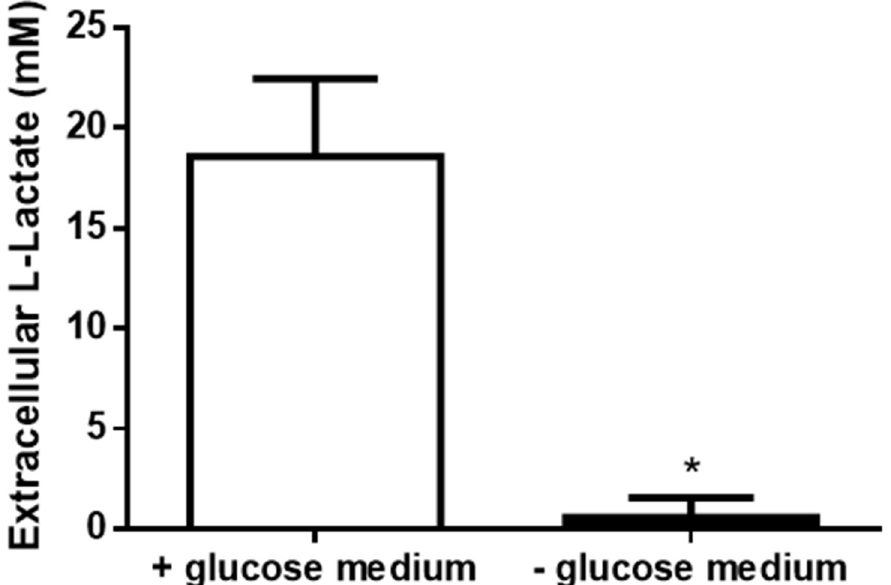
Fig 4. Effect of glucose starvation on lactate levels. Extracellular lactate level in pII cells upon culture in + glucose medium (open bar), or—glucose medium (solid bar) for 1 day was determined as described in Methods. Histobars represent means ± SEM of at least 3 independent determinations. � denotes significant difference from cells cultured in + glucose medium, with p < 0.05.